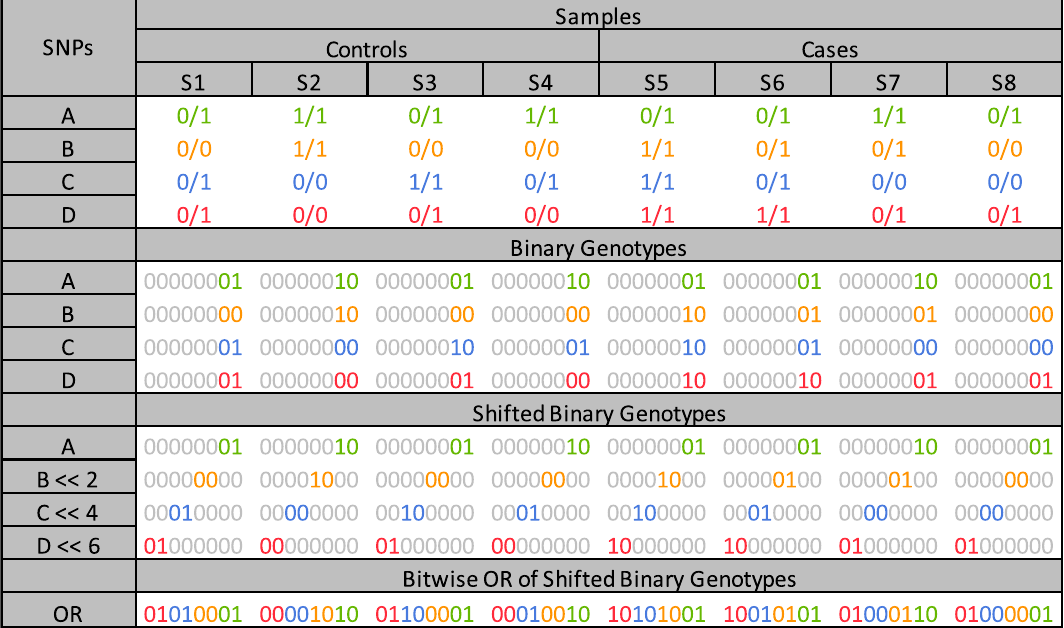
Figure 1. The bitwise representation of four example SNVs (A, B, C, and D) and the shifted bit-vectors as well as combined be double the length and a linear reading of it would take twice as long. The current solution hence represents the optimal trade-off between speed and complexity. Figure 1 is an example that shows the binary representation of genotypes of four different SNVs: A, B, C and D across eight samples (four cases and four controls). The second, third and fourth SNVs are then shifted to the left by 2, 4 and 6 bits, respectively. Next, all four SNVs are combined using bit-wise OR operations. These two steps are also shown in Fig. 1. In the resulting array, each byte represents a genotype combination for a sample (a row in the contingency table). For example, 00010010 (for sample S4) represents the row in which D and B have the 0/0 genotype, C has the 0/1 genotype and A has the 1/1 genotype. To form the contingency table, BitEpi loops through the OR vector and counts the occurrences of each byte. BitEpi eliminates the shift operations at each test by pre-computing 2, 4 and 6 bit shifted versions of the entire dataset (producing three extra copies) and storing them in memory before the analysis. Since the number of SNVs for an exhaustive epistasis analysis is limited, the redundancy in memory usage and the time to pre-compute shifted datasets are negligible. Our 1-Vector bitwise approach is different from the 3-Vector bitwise approach used in BOOST and MPI3SNP. Algorithms 1 and 2 illustrates the 3-Vector and 1-Vector bitwise approaches to compute one column of the contingency table in a m -SNVs interaction (i.e case column or control column). Both cohorts can be processed using the same algorithm. Here, C represent a column of the contingency table where C [ i ] is the number of samples in the i th row of the table ( i starts from 0). { P [ 1 ] · · · P [ m ]} represent m SNVs and R is a temporary variable (a 64-bit machine word). In Algorithm 1, each SNV is encoded into three bit-vectors, v [1], v [2] and v [3]. Each bit-vector corresponds to a genotype (0/0, 0/1 and 1/1 respectively). For P [ i ], if the j th sample has the 0/1 genotype, then the j th bit in P [ i ]. v [2] is set to 1. Each bit-vector is stored in an array of 64-bit machine words where each word contains the information for 64 samples (1 bit per sample). Thus the parallelization factor is 64 samples per operation. P [ i ]. v [ j ] [ k ] represents the k th word of the j th vector of the i th SNV. There are ⌈ s 64 ⌉ words in each vector where s is the number of samples in the cohort (i.e. cases or controls). The core operation of Algorithm 1 includes m bit-wise AND operations, a BitCount operation to count number of set bits (1’s) in the result of AND operations ( R ) as well as an ADD operation. In this program there are m nested loops each iterating from 1 to 3. x i is the iterator for the i th loop. These loops result in the complexity of 3 m s to perform each test.